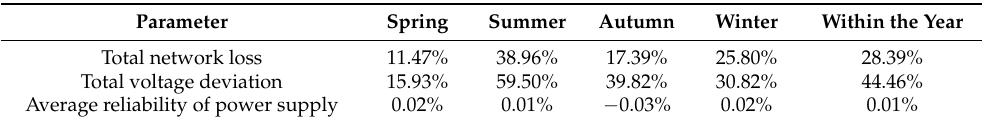
of power supply after reconfiguration. power supply after